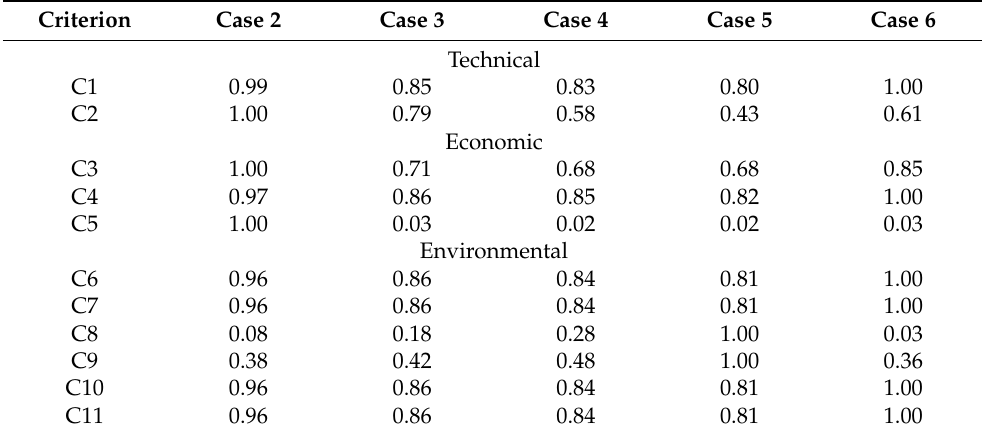
Table 9. Normalization of